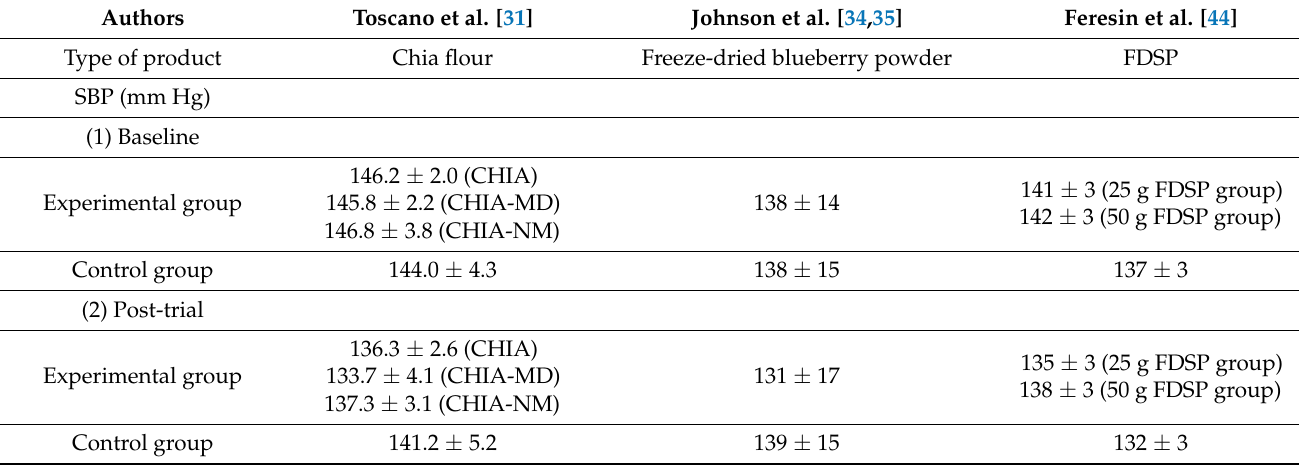
Table 5. Effects of specific nutrients on SBP values.